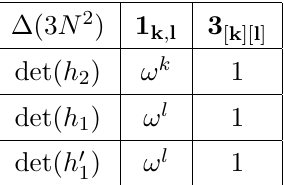
Table 2 . Determinants over the generators of (cid:1)(3 N 2 ) where N= 3 2 Z , for all irreducible represen- tations of the group. ! is the cubic root of unity, ! 3 = 1, while h 1 , h 0 generators of the group. Finally, the k; l indices simply indicate di(cid:11)erent irreducible representations | see [24] for a detailed discussion of the group properties of